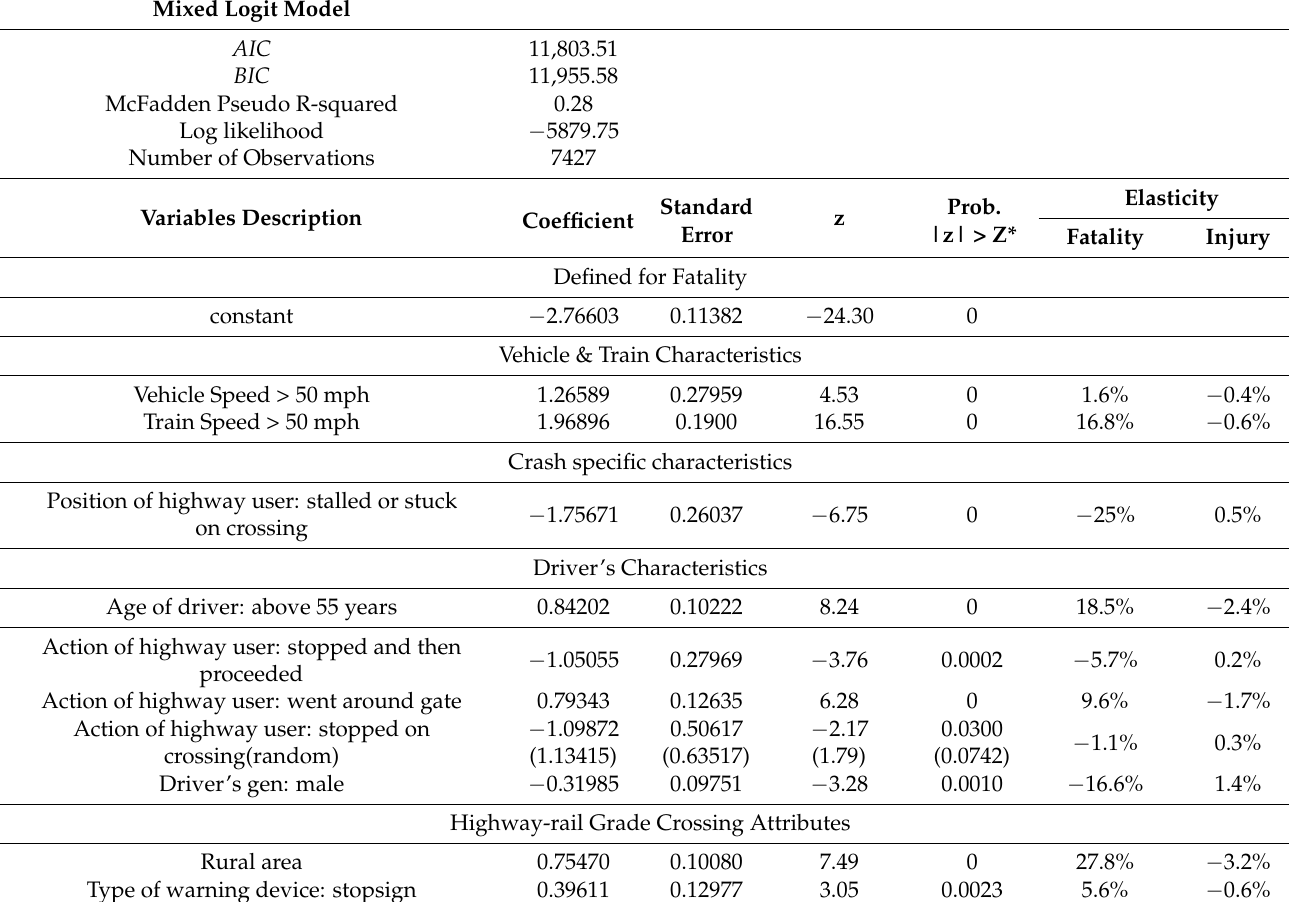
Table 5. Results of auto model